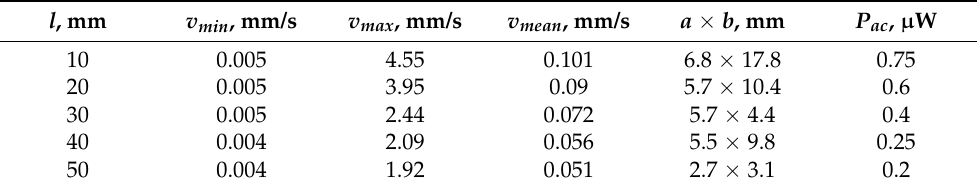
Figure 10. Amplitude–frequency spectra of vibrations in CFRP composite (frequency range from 50 Hz to 20 kHz, emitter–sample distance varies from 10 to 50 mm). Table 2. Amplitude–frequency characteristics of vibrations in CFRP composite at different distances between emitter and sample (sample size 100 × 75 × 1.1 mm 3 and impact damage 15